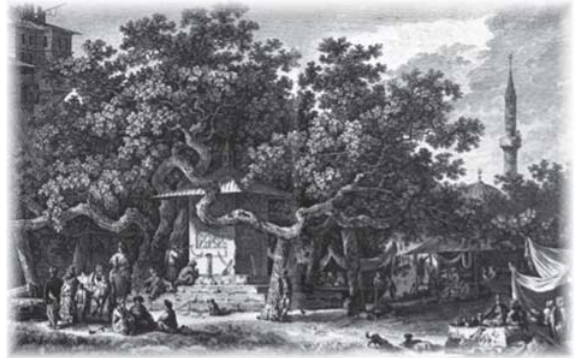
Figure 1 - The famous plane tree in the island of Kos,